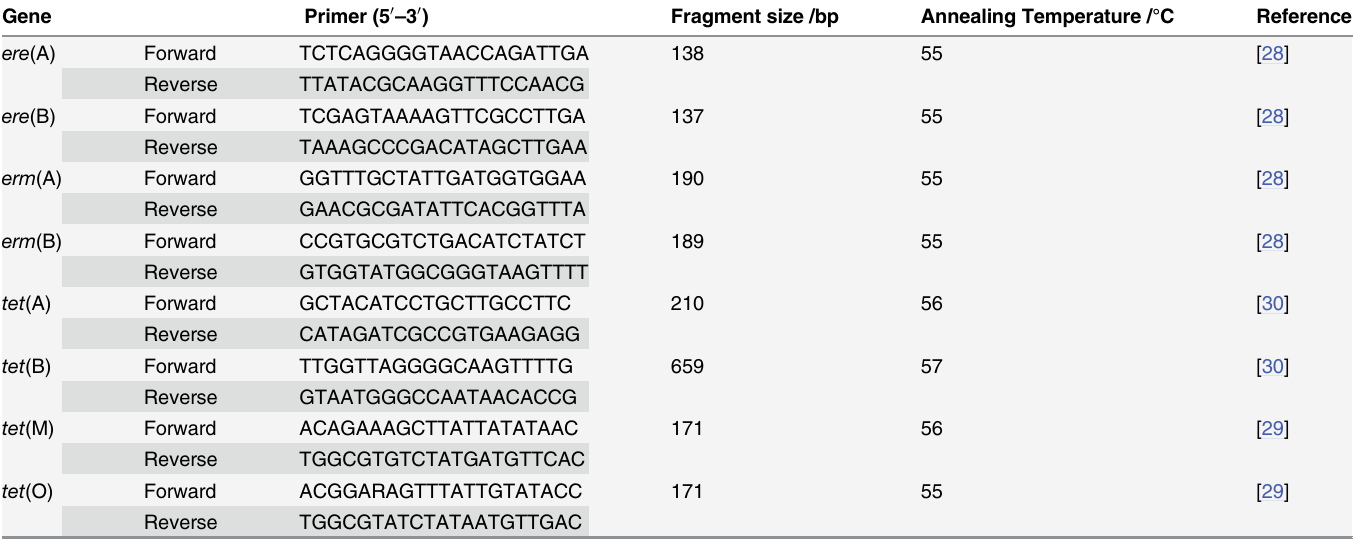
Table 1. The primers of four ERY and four TC resistance genes used in the study.